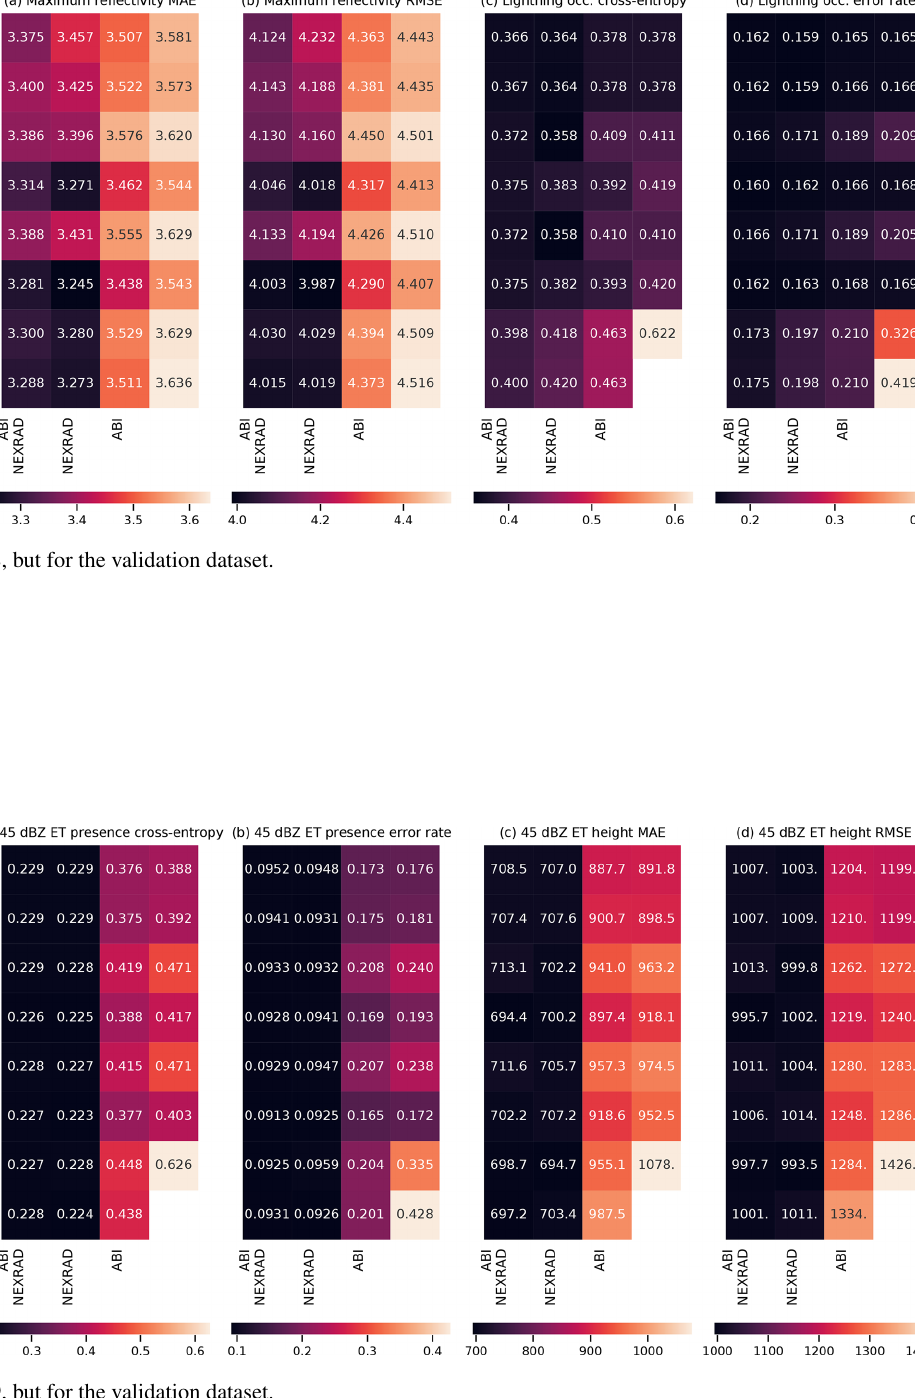
Figure A4. As Fig. 9, but for the validation